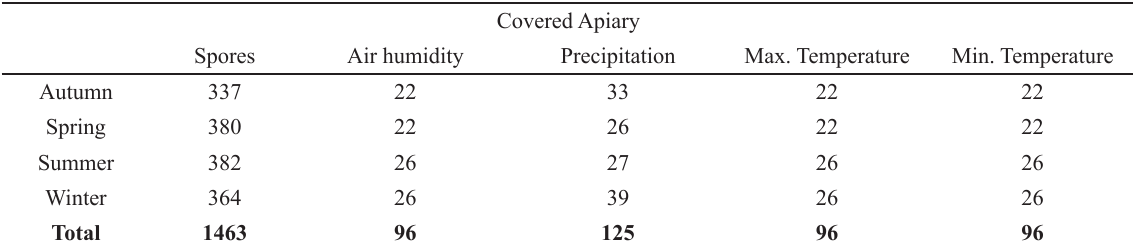
Table 2 . Sampling number (N value) for each studied variable on roofed apiary: Spores (honey bee samples), air humidity, precipitation, maximum temperature, and minimum temperature.